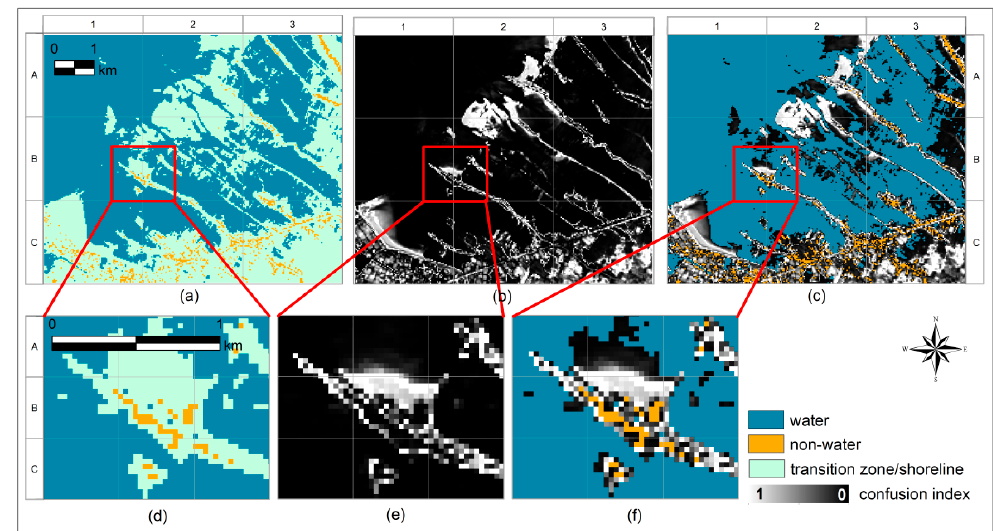
Figure 4. The representation of fuzzy-crisp object model: ( a ) the core of water and non-water objects, and shorelines ; ( b ) confusion index values considered for the quantification of classification uncertainty; and ( c ) shoreline image with fuzziness represented by confusion index. Detailed presentation of shorelines in red rectangle sites are displayed in ( d – f ).